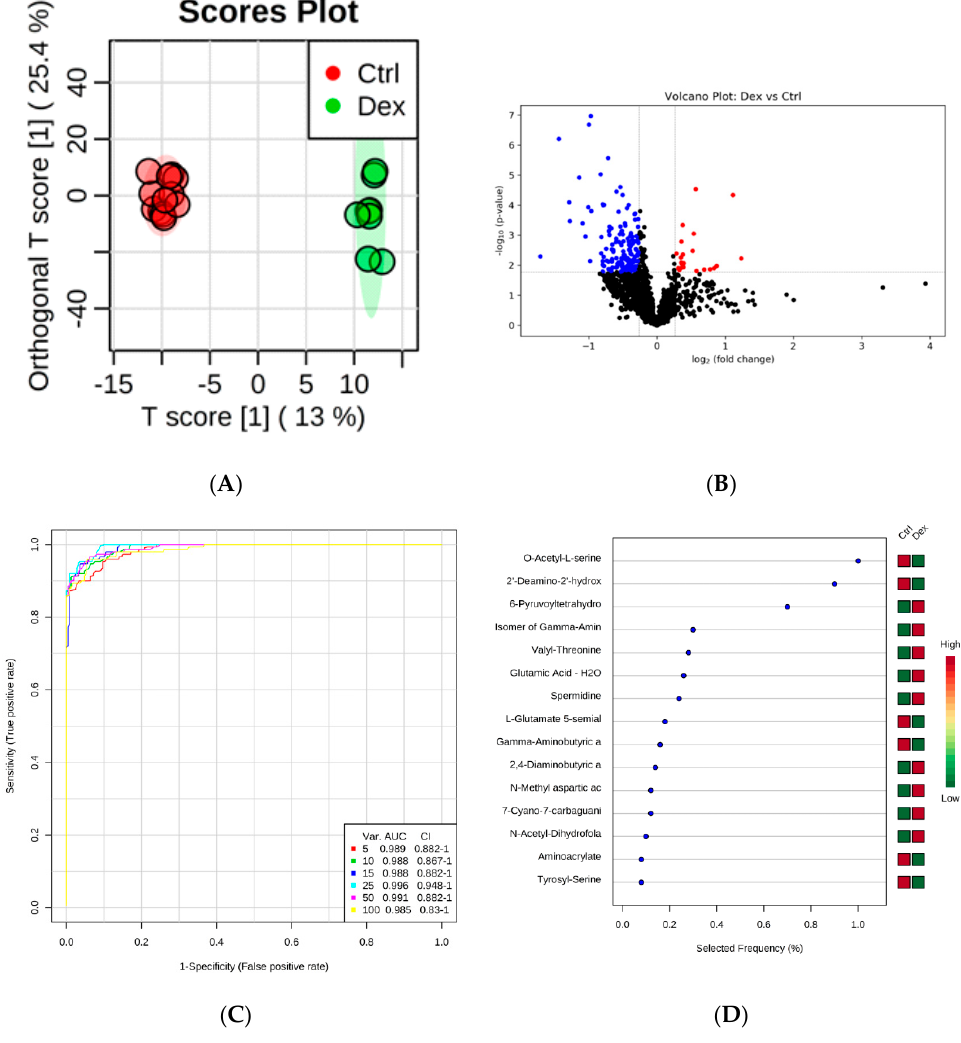
Figure 3. Rat kidney tissue submetabolomic profile after prolonged treatment with dexamethasone (Dex). ( A ) OPLS-DA score plot ( Q 2 = 0.886, R 2 = 0.994) shows a clear separation between the healthy group (Ctrl, n = 6) and Dex-treated groups ( n = 5). Tissue samples were run on LC-MS in duplicate. ( B ) Volcano plot shows the statistically significant altered metabolites filtered with q-value < 0.05, and FC > 1.2 or < 0.83. Out of 1538 detected metabolites, 162 were decreased (blue) and 24 increased (red) in Dex-treated rats compared to controls. ( C ) The ROC curve was generated by the OPLS-DA model, with AUC values calculated from the combination of 5, 10, 15, 25, 50, and 100 metabolites. ( D ) Frequency plot shows 15 positively identified metabolites.